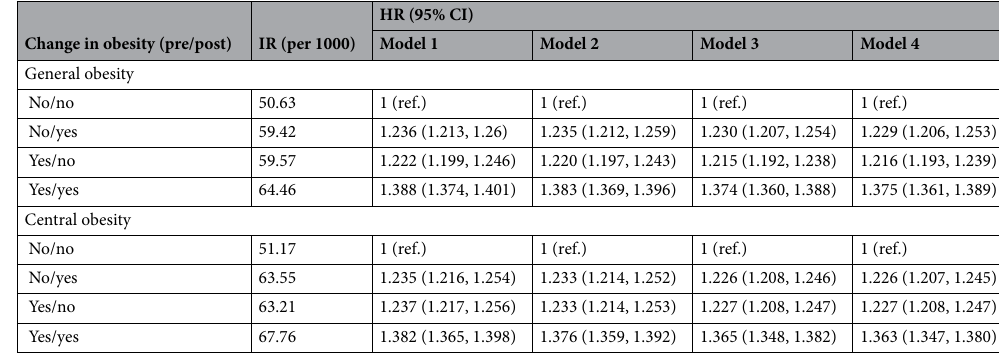
Table 5. Incidence rate and hazard ratio for the risk of knee OA according to the change in obesity status. Model 1 was adjusted for age, sex. Model 2 was adjusted for age, sex, income, smoking, alcohol intake and regular exercises. Model 3 was adjusted for age, sex, income, smoking, alcohol intake, regular exercises, diabetes, hypertension and dyslipidemia. Model 4 was adjusted for age, sex, income, smoking, alcohol intake, regular exercises, diabetes, hypertension, dyslipidemia, cancer, end-stage renal disease, chronic obstructive pulmonary disease, stroke, liver cirrhosis, hear failure, dementia and chronic kidney disease. (Pre/post) means obesity status in the preceding and subsequent health examination. HR hazard ratio, CI confidence interval, OA osteoarthritis, IR incidence rate.